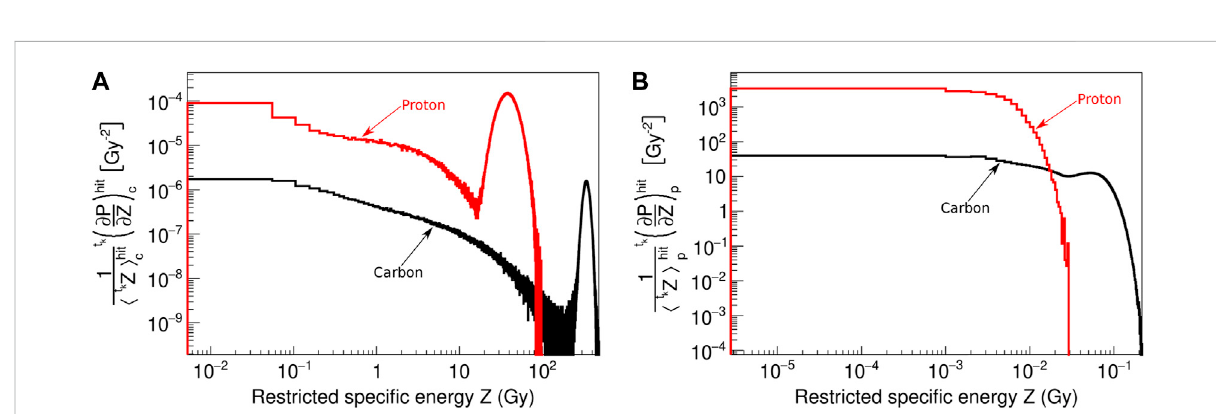
FIGURE 3 Normalizedprobabilitydistributionsof ( c k Z ) c (A) and ( c k Z ) p (B) computedwiththeLQDMCcoderesultingfromirradiationswithasingleimpact in the volume of in fl uence for 2.6 MeV protons (in red) and 12 MeV/u carbon ions (in black). The sensitive volume was modeled by cylinders with radius 4.89 μ m and length 1 μ m; notice that the latter corresponds to the lowest realistic value which may be chosen to represent nuclei thickness, andthat inthiscasethestatistical fl uctuations shouldbethemostimportant. The corevolumeisde fi nedas aparallelepiped withasquare cross section of 200 nm edge.